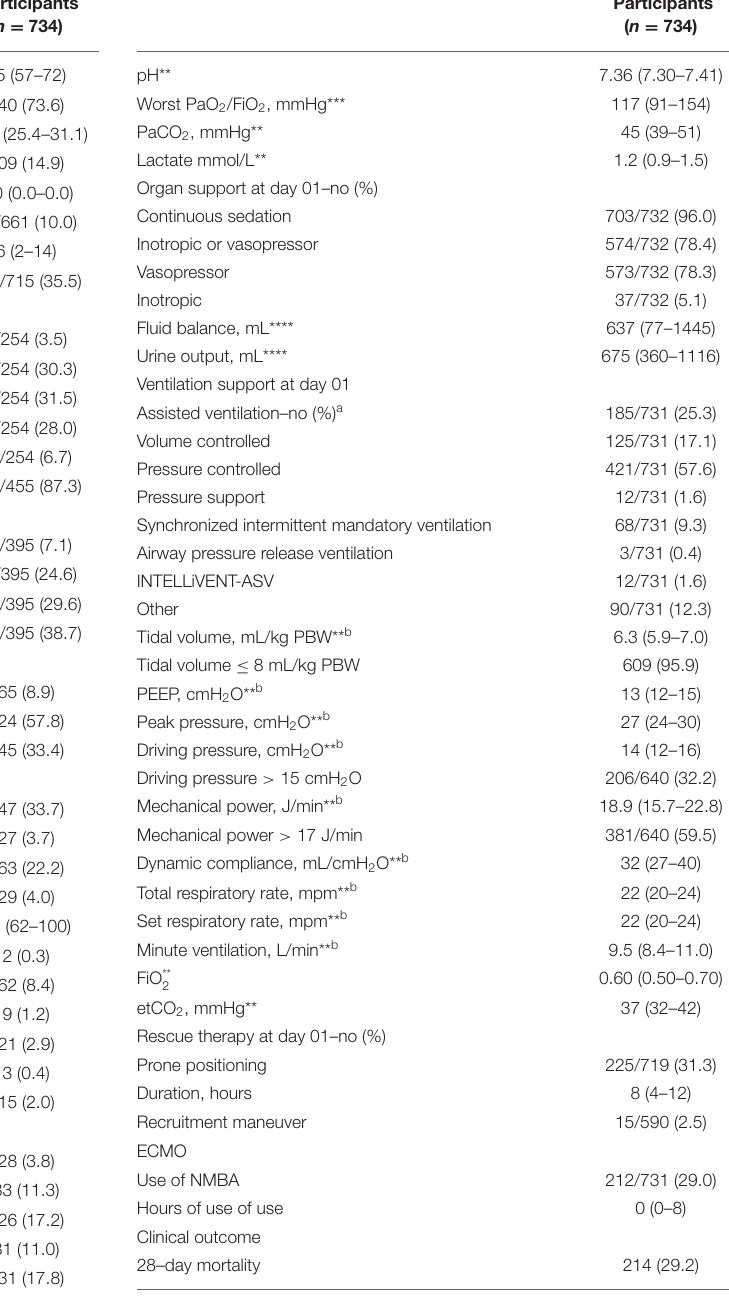
TABLE 1 | Baseline patient characteristics and